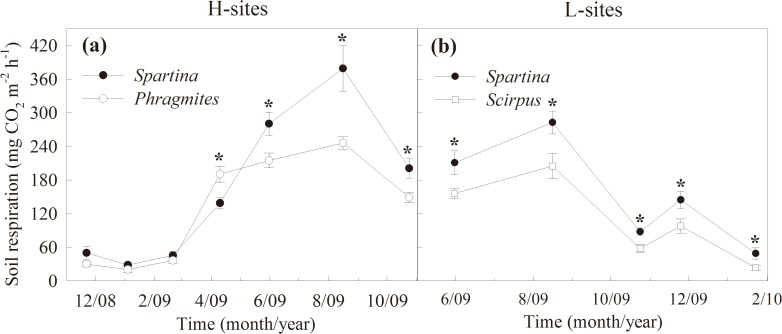
Temporal variations in soil respiration in different plant stands.Temporal variations in soil respiration under S. alterniflora (Spartina) and P. australis (Phragmites) stands in the H-sites, and S. alterniflora and S. mariqueter (Scirpus) stands in the L-sites. Bars represent mean ± SE (n = 9), asterisks indicate significant differences (P < 0.05) between means of different stands.